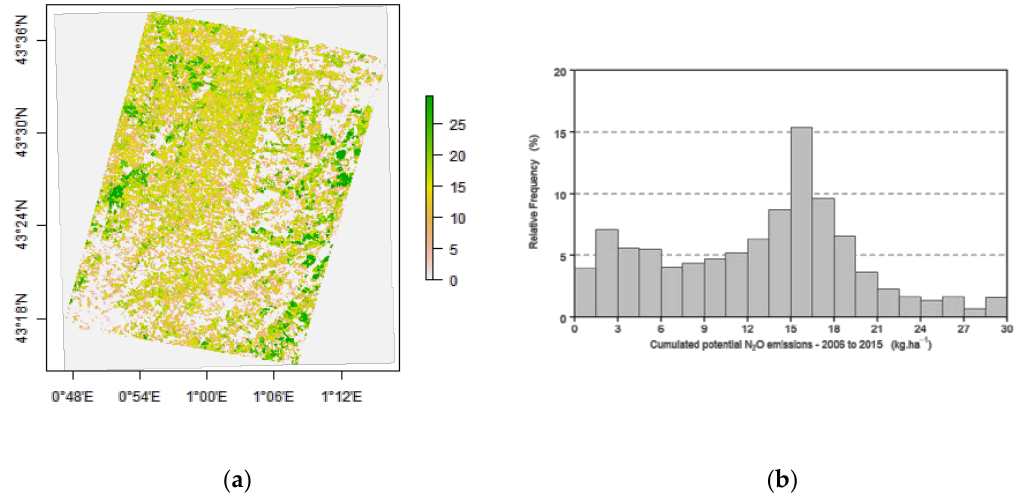
Figure 10. Ten-years map of the potential N 2 O budget estimated over the study area ( a ), together with the corresponding histogram derived from the potential emitting areas highlighting the relative occurrence of each potential N 2 O emissions range ( b ).